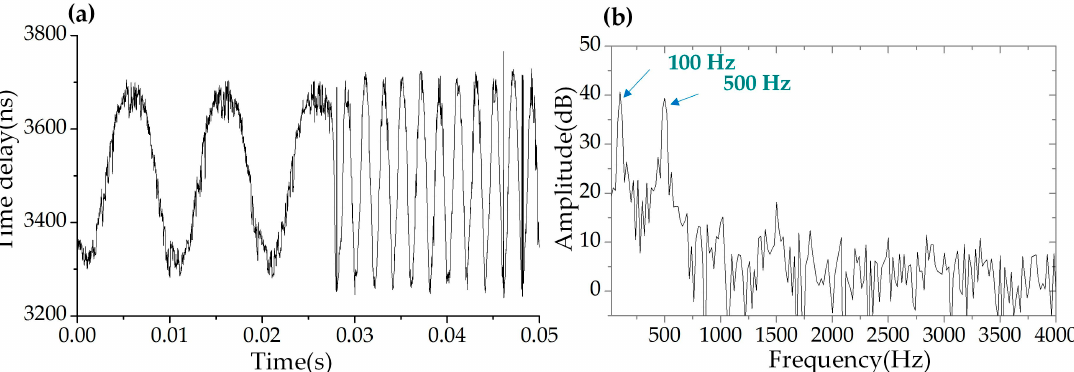
Figure 11. The interrogation result based on the WSSL at 40 kHz swept rate when the driven signal was 100 Hz. ( a ) The calculated time delay of the reflected pulses between the reference and sensing FBGs. ( b ) The power spectral density of the FFT spectrum of ( a ).